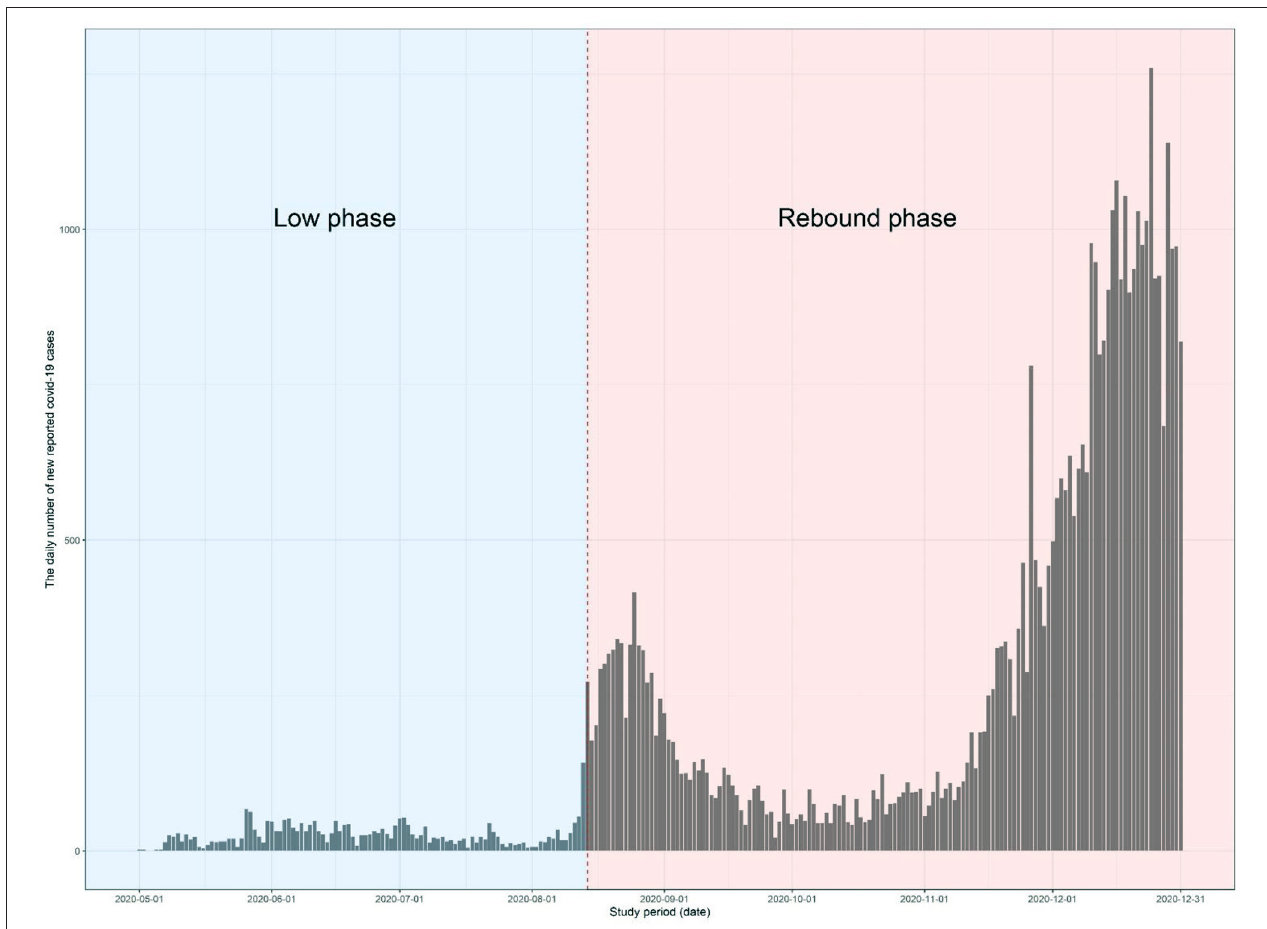
FIGURE 1 | The epidemic curve of coronavirus disease 2019 (COVID-19) in the Korea during the study period (from May 1 to August 14, 2020, for low phase and from August 15 to December 31, 2020, for rebound phase). The gray bar represents the daily number of newly reported COVID-19 cases.